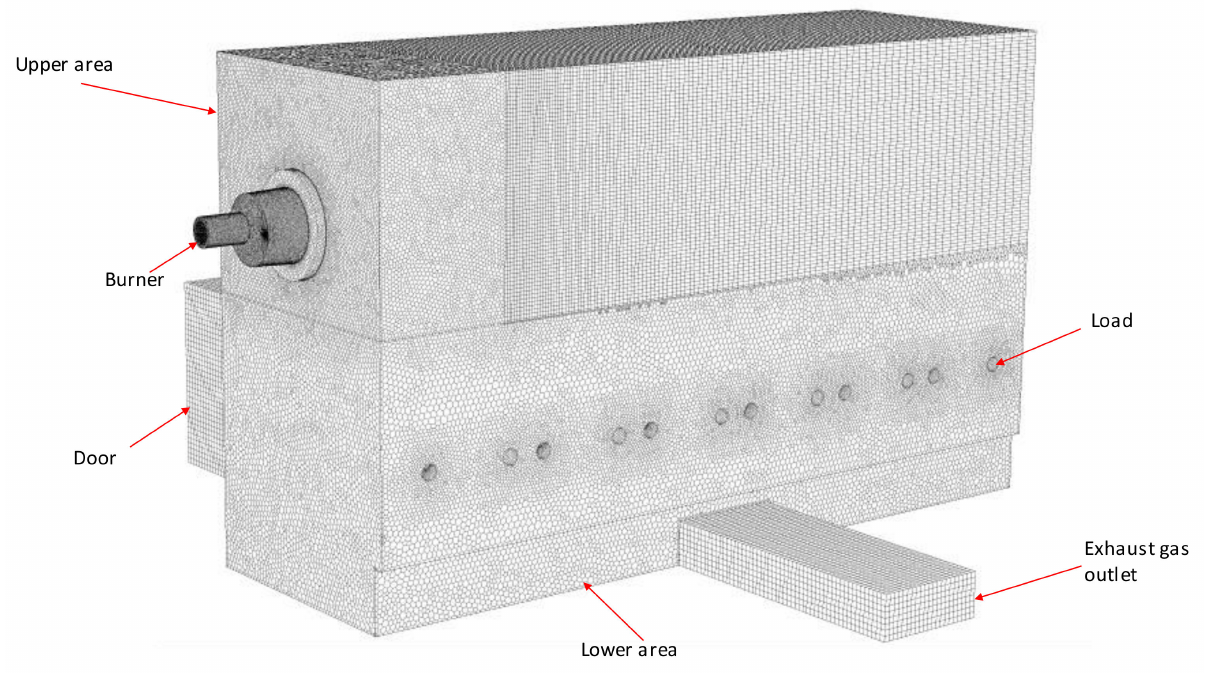
Figure 3. General view and parts of the mesh of the test